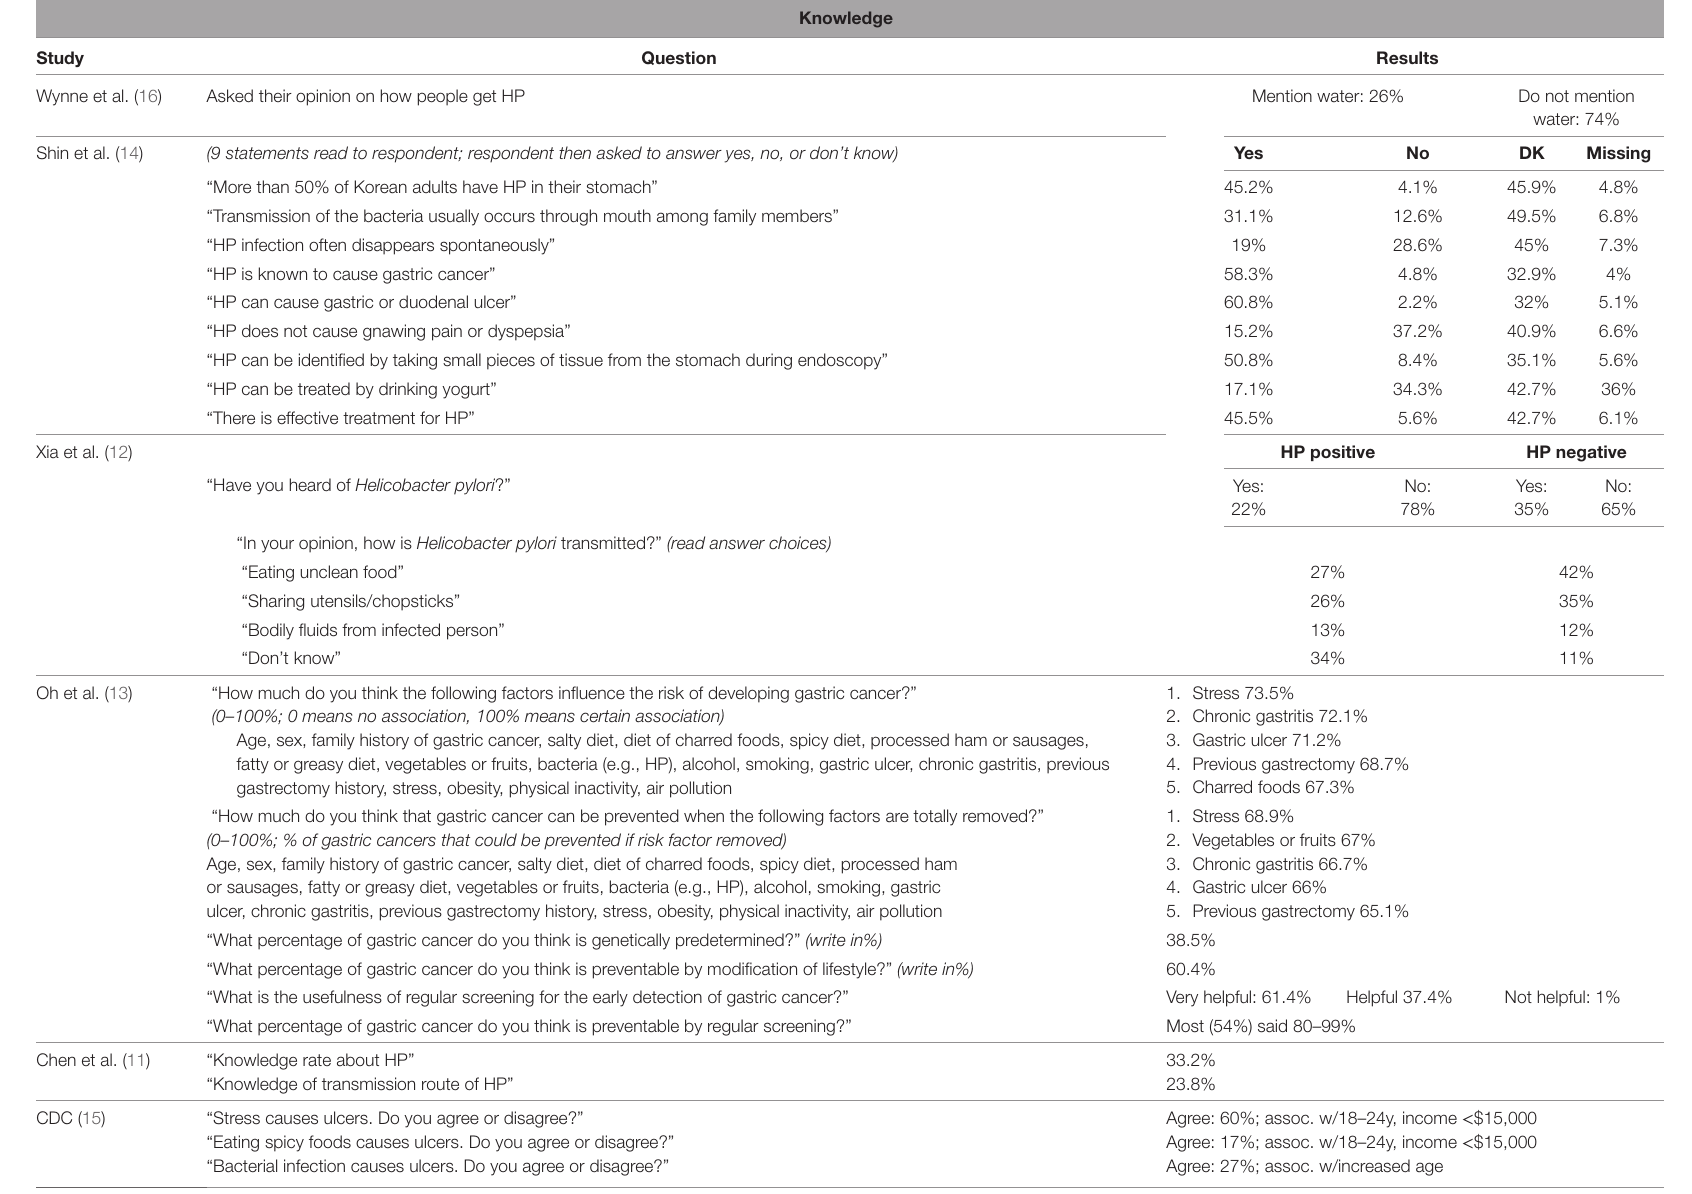
TABLe 1 | Summary of questions and replies nested within studies and ordered by publication date for knowledge, attitudes, and practices. Word-for-word questions taken from literature are indicated by